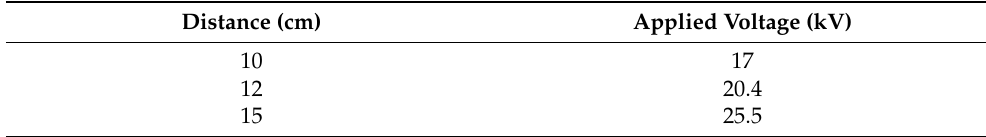
Table 2. Electrospinning distances and voltages to achieve 1.7